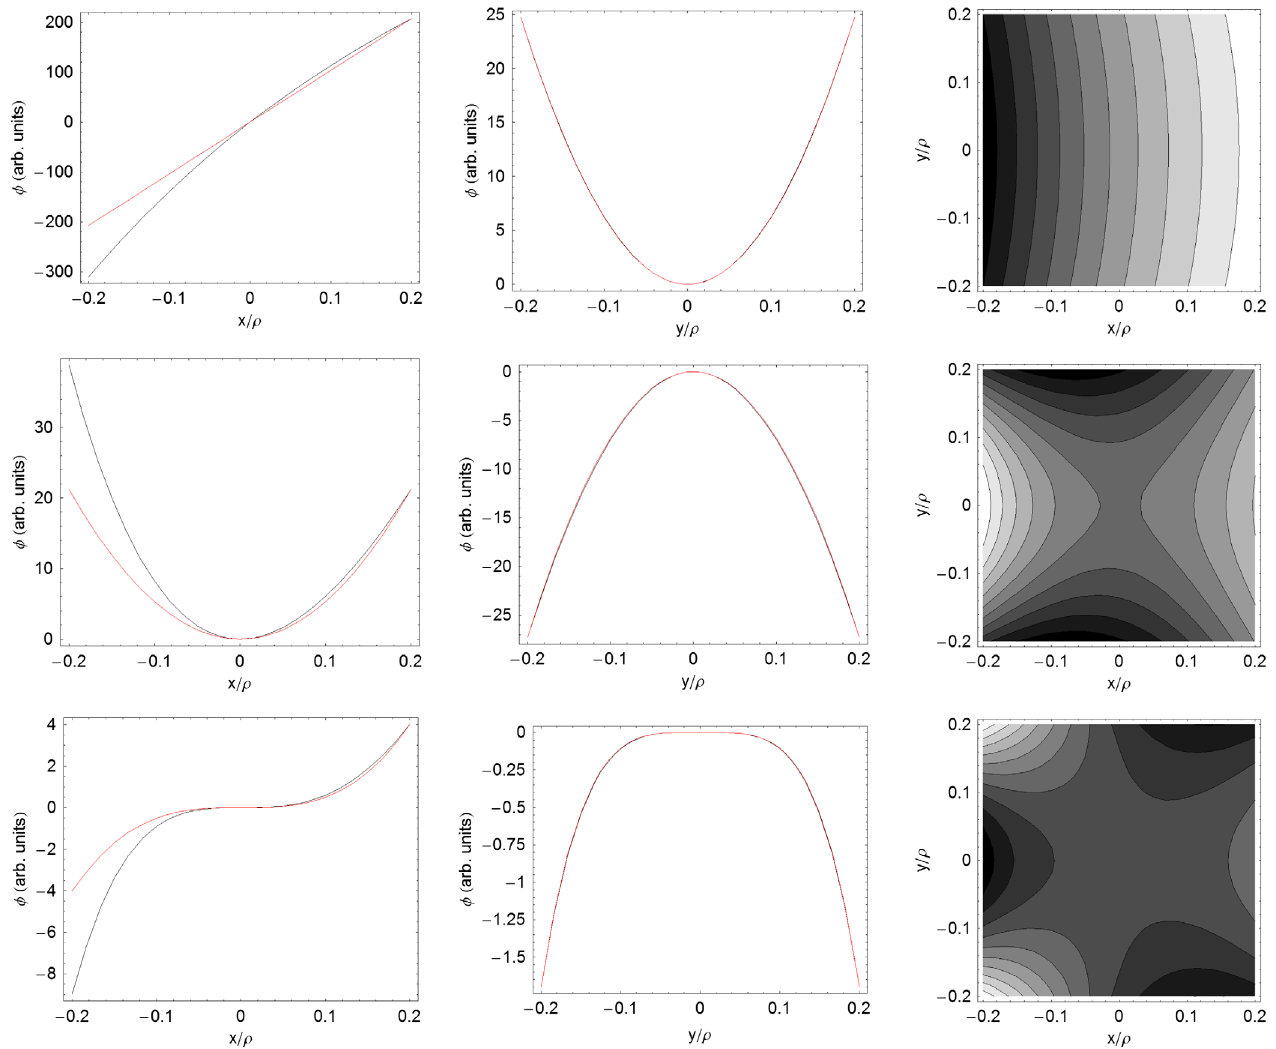
FIG. 2. Scalar potential in normal multipoles with a curved reference trajectory. Each row shows (top to bottom) the potential in a multipole of the order of n ¼ 1 (dipole), the order of n ¼ 2 (quadrupole), and the order of n ¼ 3 (sextupole). The left-hand and middle plots in each row show, respectively, the potential (black line) as a function of horizontal position x , with y ¼ 0 , and as a function of vertical position y , with x ¼ 0 . The red lines in the left-hand plots show curves ϕ ∝ x n . The red lines in the middle plots show curves ϕ ∝ y n þ 1 for odd n and ϕ ∝ y n for even n . The right-hand plot in each row shows contours of constant potential in the plane perpendicular to the reference